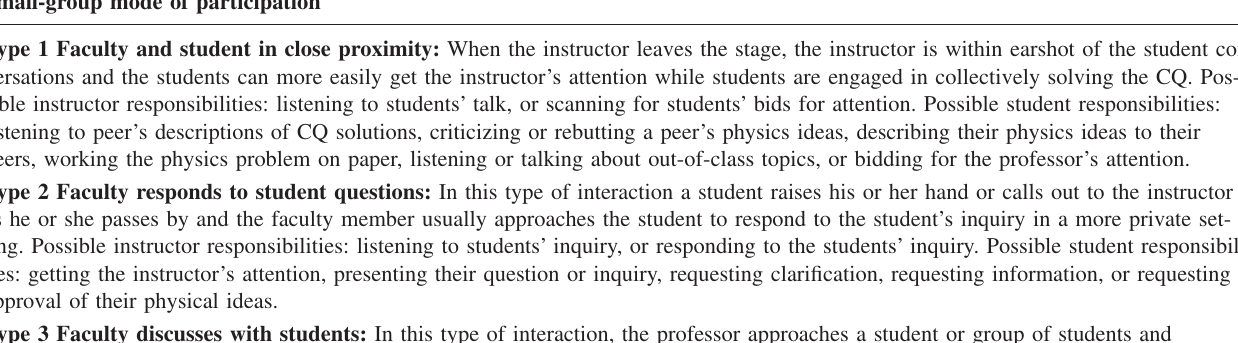
TABLE II. Types of